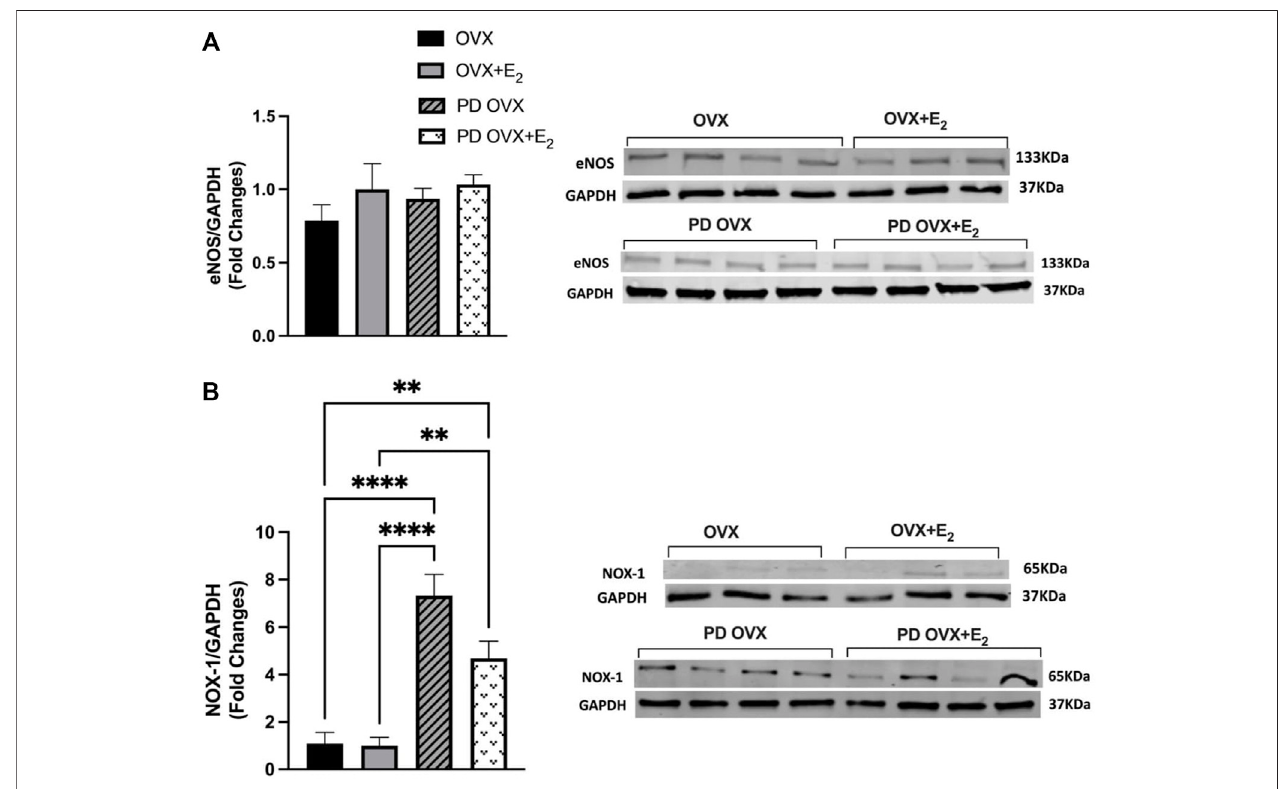
FIGURE 7 | Western blot analysis of (A) eNOS and (B) NOX-1 expression in mesenteric arteries of ovariectomized (OVX) and E2 replaced (OVX+E 2 ) control and prediabetic (PD) rats. Protein levels were quanti fi ed by densitometry and normalized to corresponding GAPDH. Values are represented as mean ± SEM. Each bar represents the values obtained from n = 3 – 4 animals per group. Representative bands of target and housekeeping protein (GAPDH) were shown from the same membranes. Capped lines indicate signi fi cant differences between two groups (** p < 0.01, **** p < 0.0001), analyzed using one-way ANOVA followed by Tukey ’ s post hoc test. eNOS, endothelial nitric oxide synthase; NOX-1, NADPH